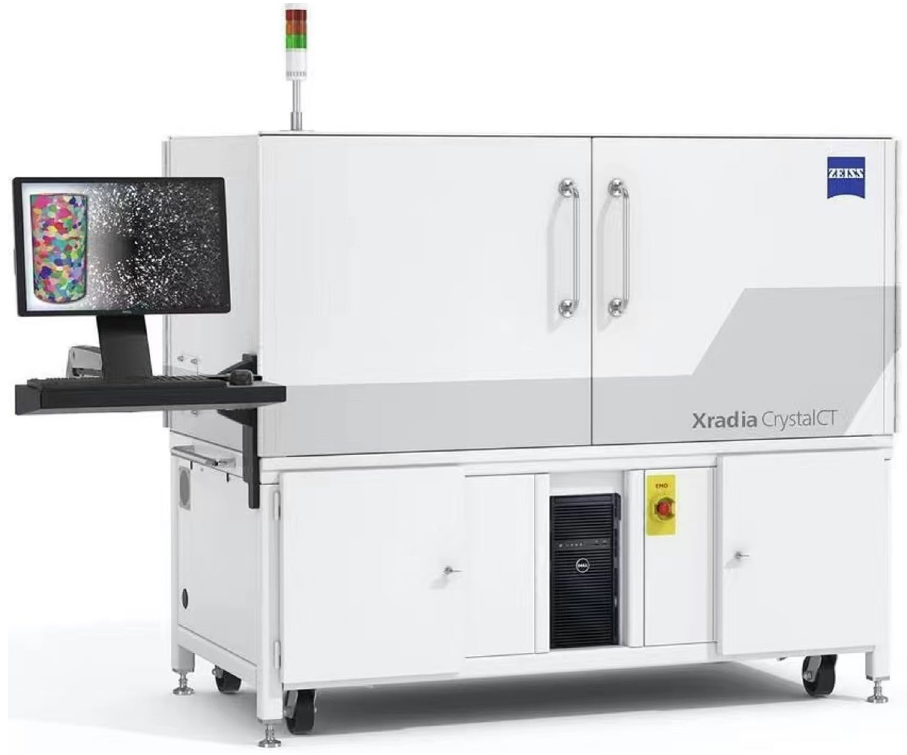
Fig. 2 The instrument used in the experiment was Zeiss Xradia Crystal CT